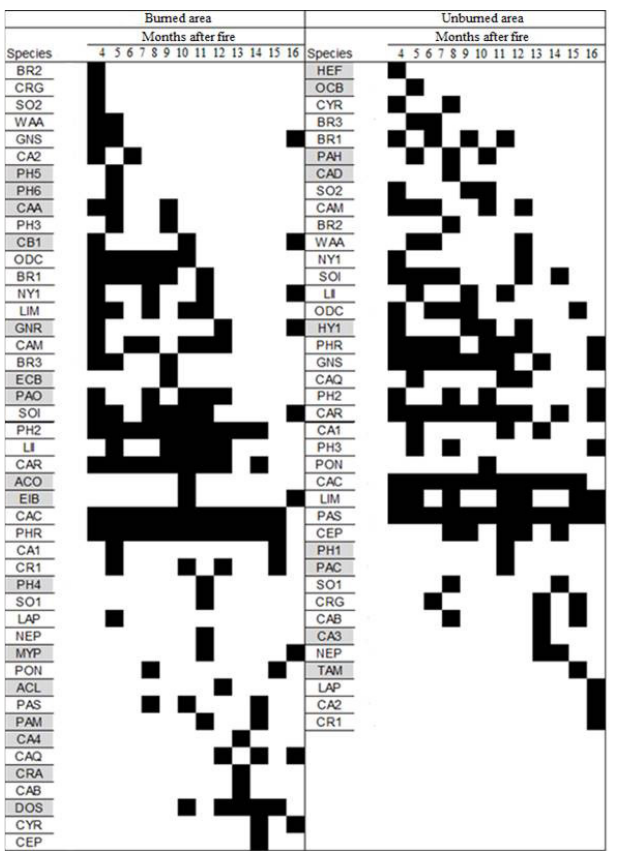
Fig 3 . Temporal changes in the ant species fauna of both studied areas through the model ‘Seriation’. A gradient of species replacement over time was observed in the burned area (right panel) and which did not occur in the unburned area (left panel). The species names are in abbreviations, which grey for exclusive species and white for represent common